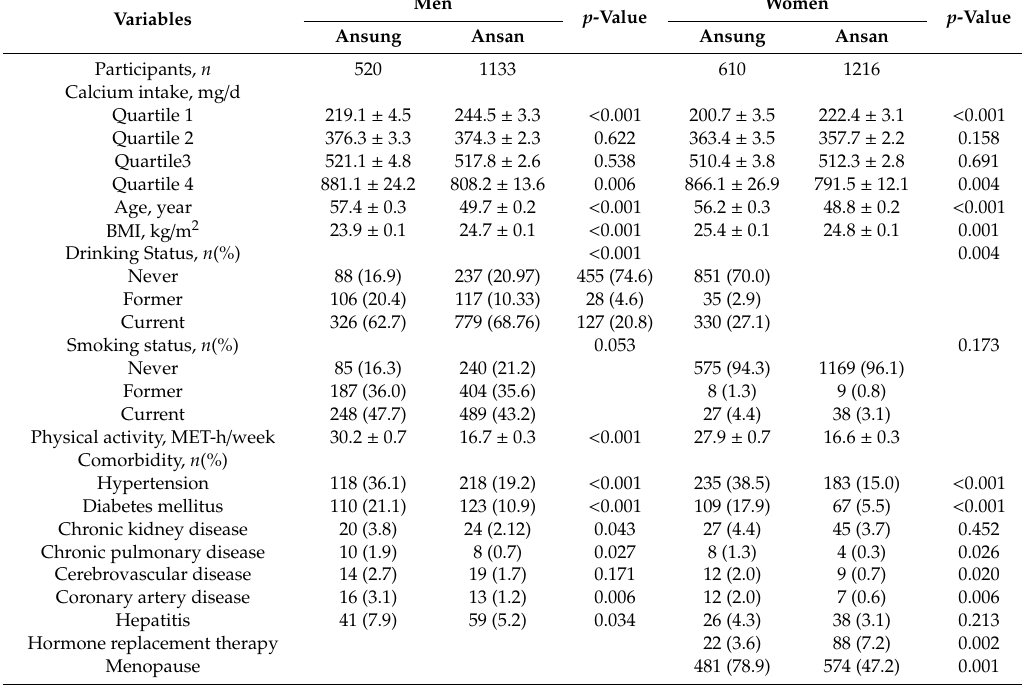
Table A1. Baseline characteristics in men and women with or without peptic ulcer disease in Ansung and